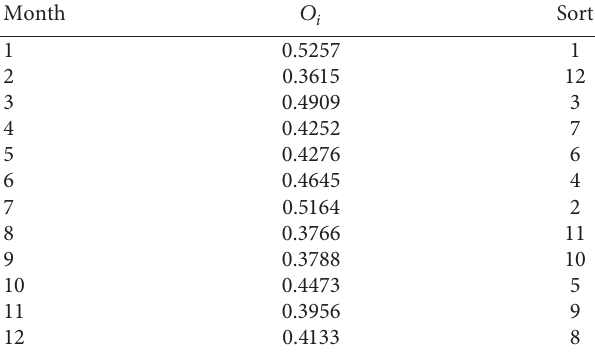
Table 7: The relative proximity degree of the integrated collection and distribution system of Tongchuan Railway Depot in each month in 2018.